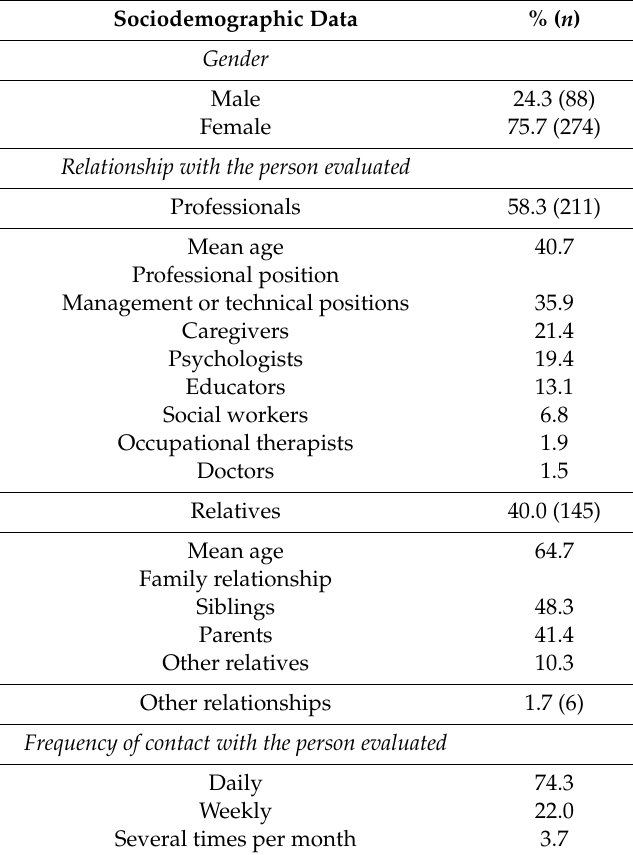
Table 2. Sociodemographic data of